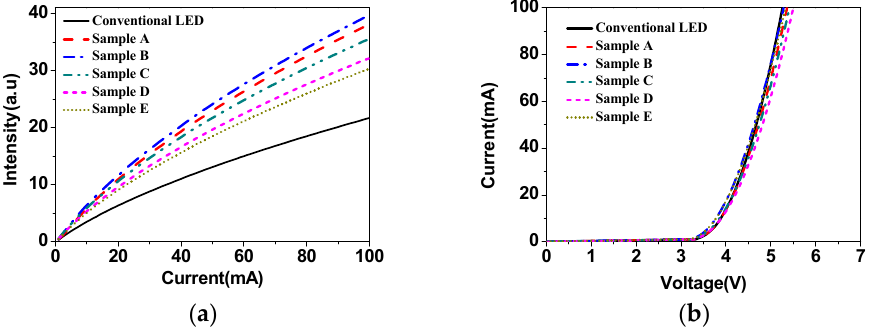
Figure 1. ( a ) Schematic illustration of the LED with ITO nanopillar array. ( b – f ) 30 degree tilt SEM images of the ITO nanopillar of samples ( b ) B, ( c ) C, ( d ) D, ( e ) E, and ( f ) F. Figure 2a illustrates the injection current-light output (I-L) characteristics from var-